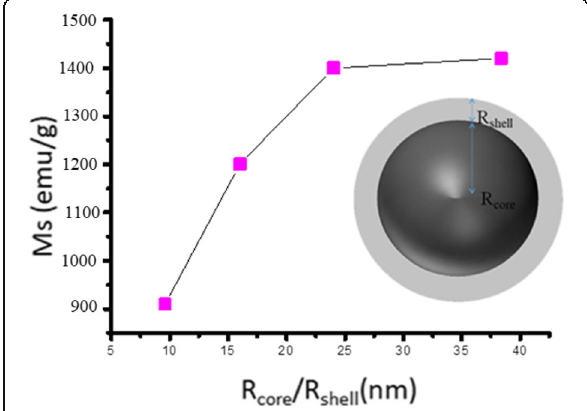
Fig. 12 Ms Vs R core /R shell curve, taking the average diameter of Fe NCs 96 nm